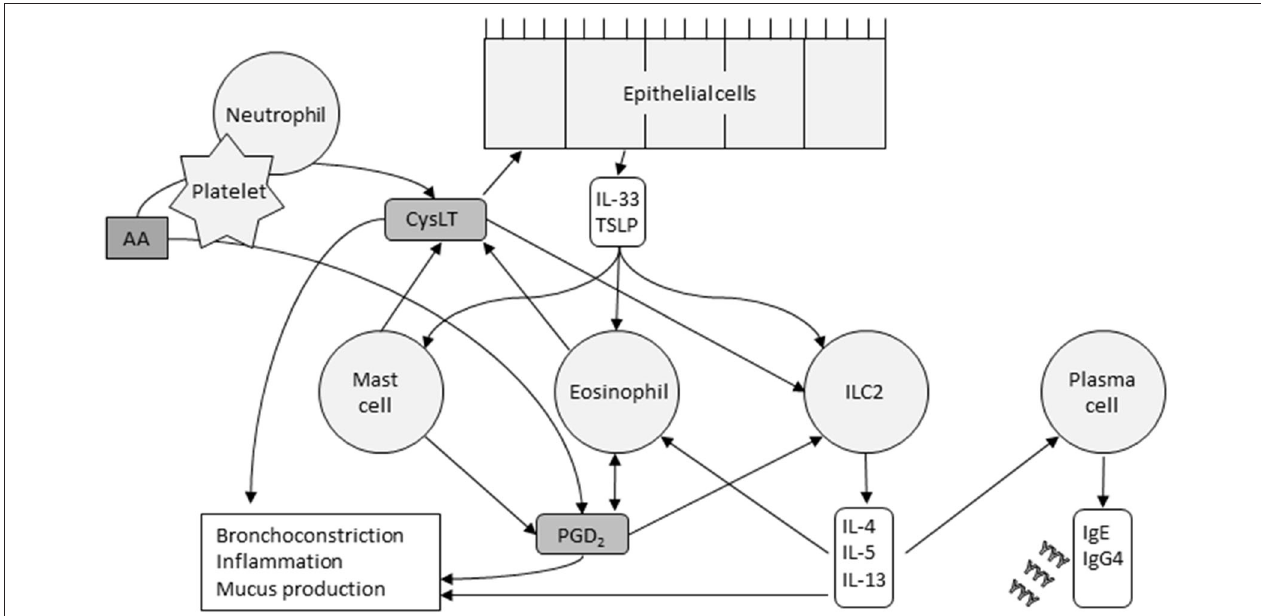
FIGURE 2 | Cells and their major interactions in AERD. CysLTs released by mast cells, eosinophils, and platelets cause epithelial release of IL-33 and TSLP. These innate cytokines in turn activate mast cells, eosinophils, and ILC2s. The cytokines released by ILC2s, the pathways of which are now targeted by several monoclonal antibodies, stimulate plasma cells to produce IgE and IgG4, and promote, recruit and activate eosinophils. Eosinophils and ICL2s are also activated by PGD 2 . Platelets metabolize arachidonic acid (AA) into PGD 2 , and, in collaboration with neutrophils, CysLTs. The inflammatory response is driven by multiple factors.